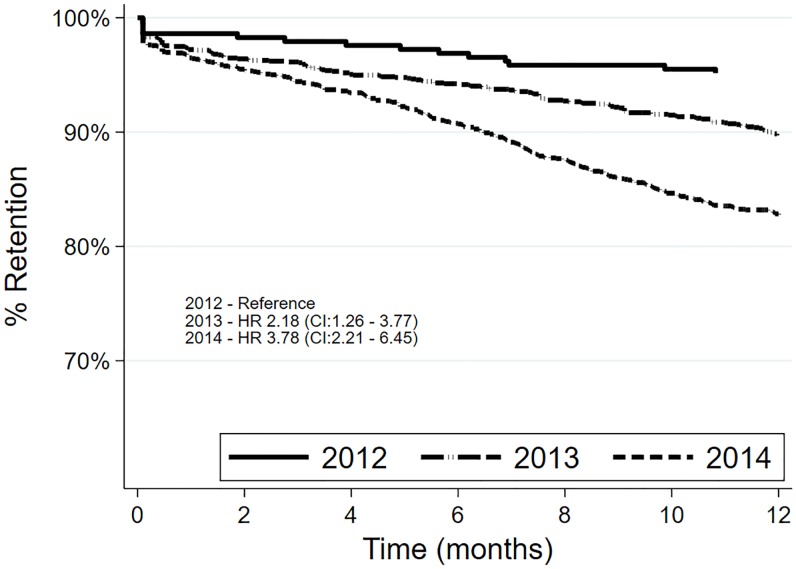
Comparison of retention rates of patients who started antiretroviral therapy in 2012, 2013 and 2014. in Zimbabwe.